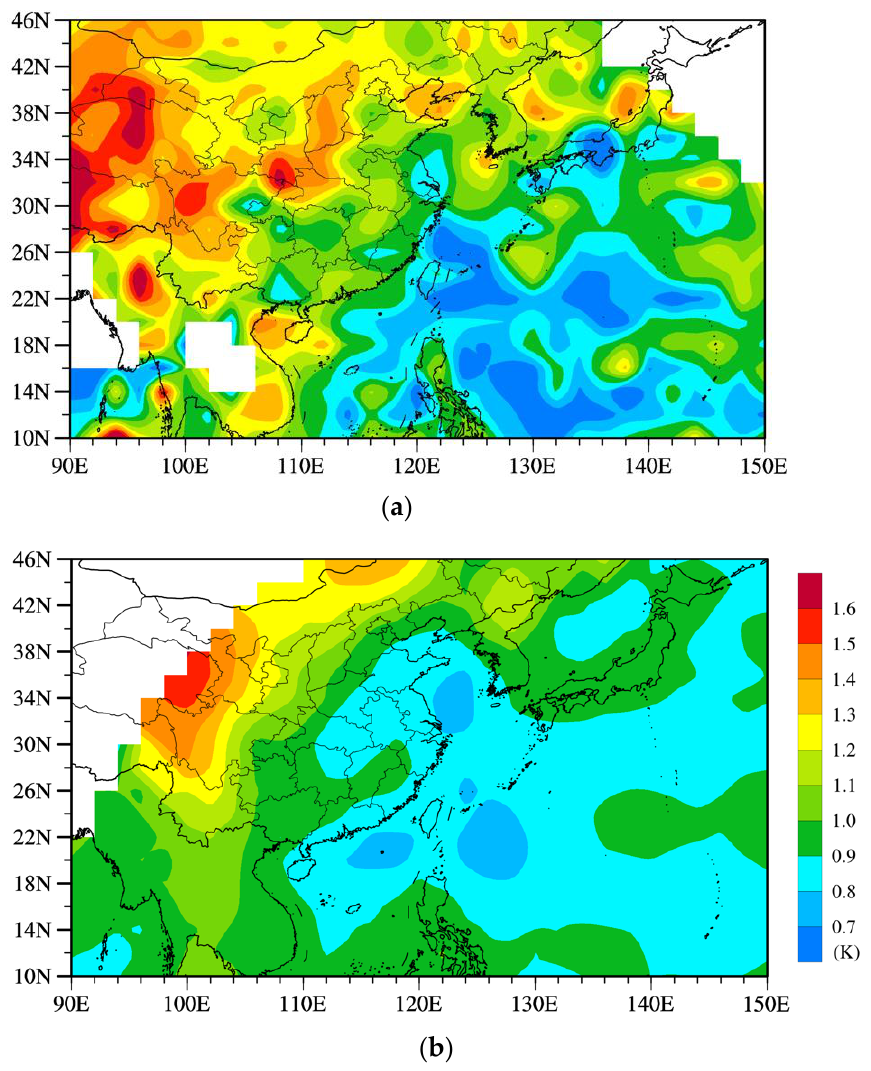
Figure 4. Spatial distributions of the O-B standard deviation (unit: K) of the AGRI, channel 14 ( a ) and the AHI, channel 16 ( b ) calculated from the one-month data.